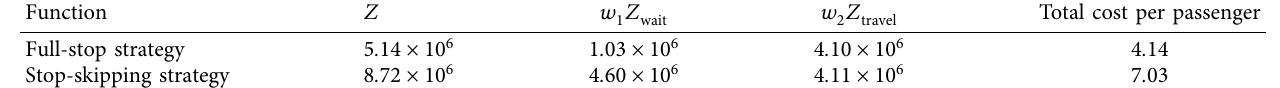
Table 2: Objective function values of full-stop strategy and stop-skipping strategy (dollars).